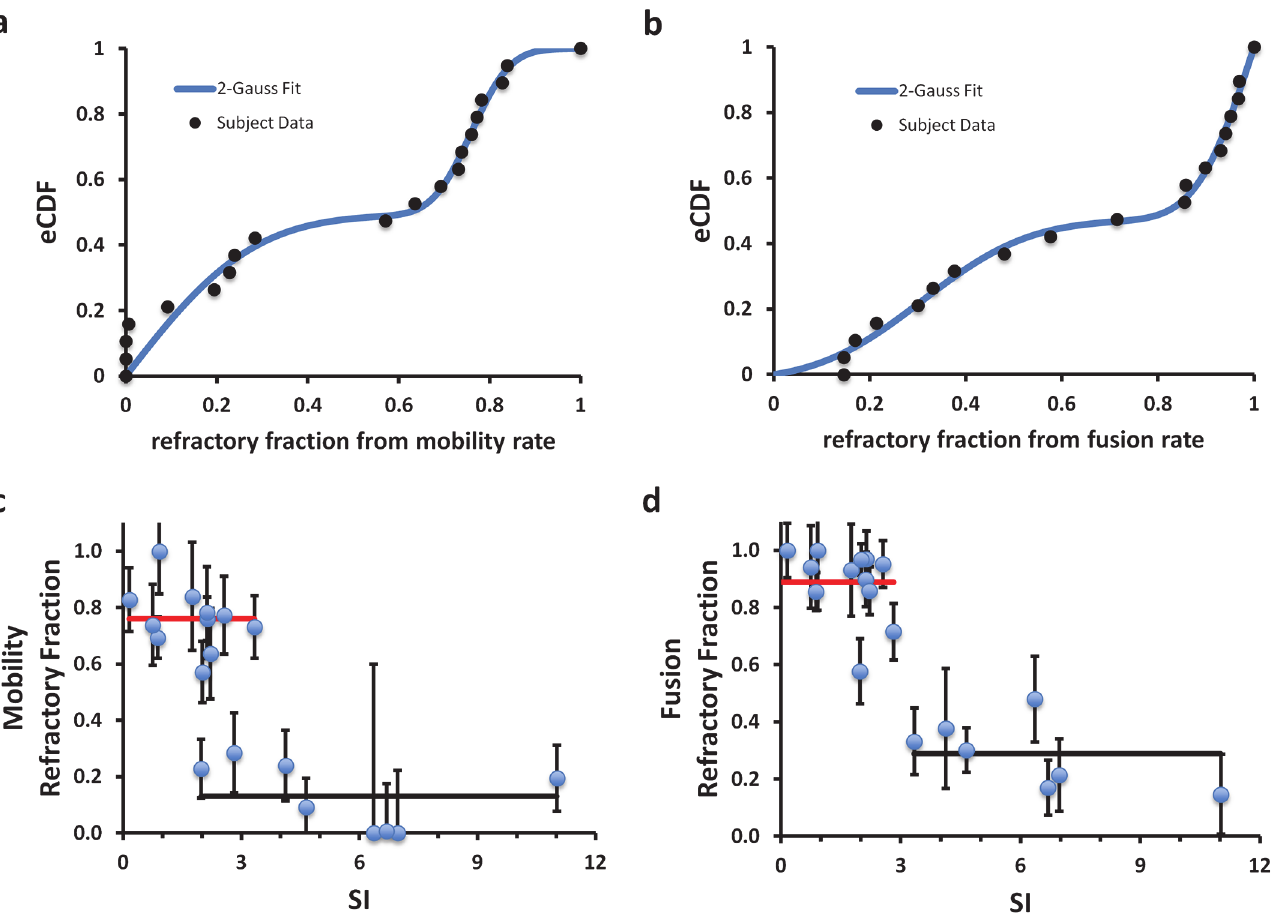
Fig 9. Refractory fractions obtained from both mobility (a) and fusion (b) data, cluster into two populations whose CDF is described best by the sum of two 0 – 1 truncated gaussians (blue fit). The refractory fractions correlate with decreasing insulin SI of the donor subject. The solid lines (high, red and low, black) are the cluster population averages drawn to span the range of data. The overlap region along the SI axis is where switching behavior is expected to occur since subjects can have similar SI values but different refractory fractions. Please note that the error bars reflect the failure fraction fitting error (95% confidence) and not the population variance in the experimental